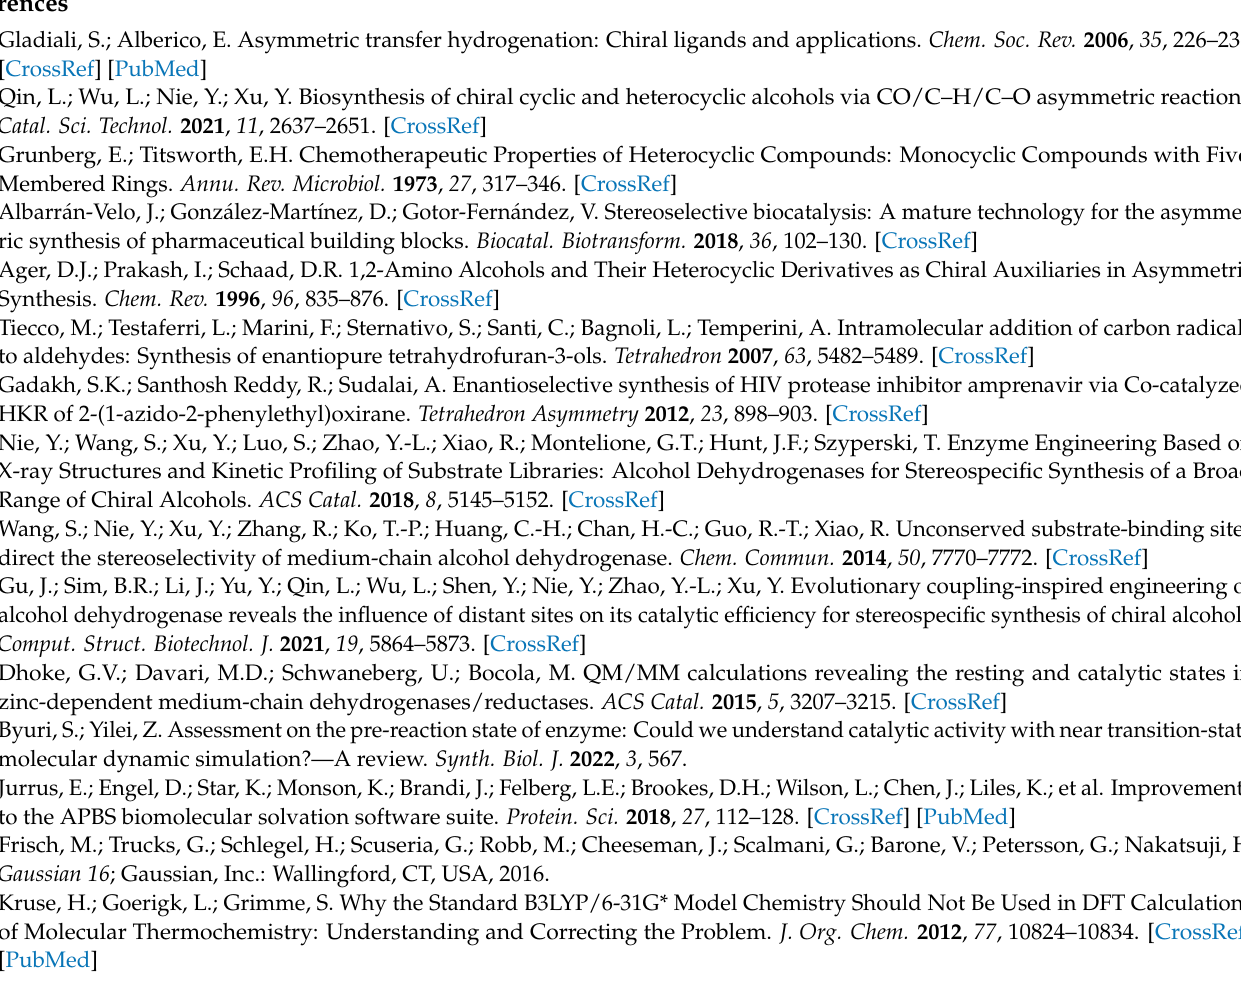
ture; Figure S4: CpRCR Residue wide RMSD measured from 100ns MD simulation for each sample; Figure S5: GC-MS chromatogram of Cp RCR-F285A, Cp RCR-W286A, Cp RCR-F285A/W286A reaction mixture; Figure S6: Amino acid sequence alignment of CpRCR with other proteins in the medium- chain alcohol dehydrogenase phylogenetic tree with >50% identity; Figure S7: Structural alignment of Cp RCR, Geotrichum candidum and Sulfolobus tokodaii labeled in red and blue arrow in Figure